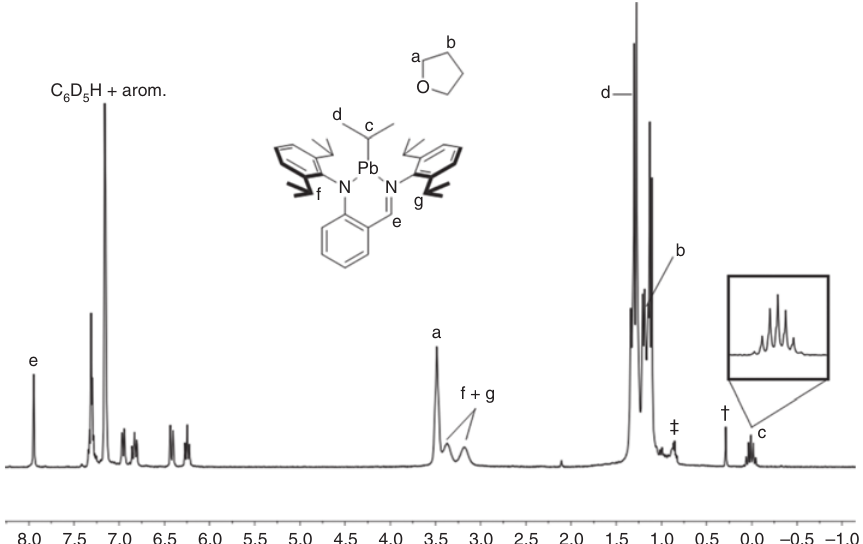
, 400 MHz, 298 K) of [{N^N iPr }Pb i Pr] ( 3 ). 6